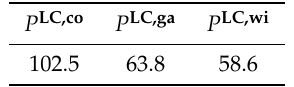
Table A2. LCOE values in